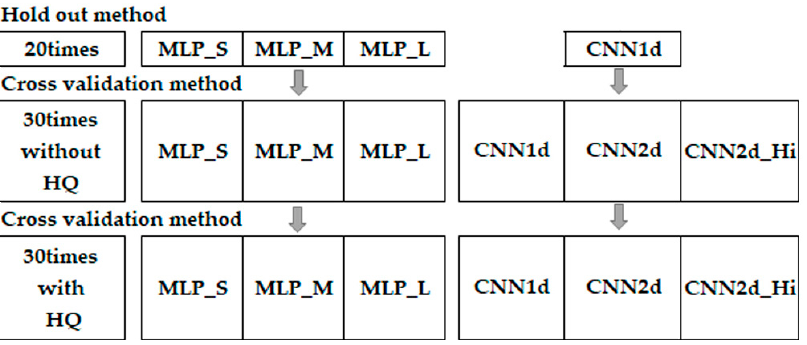
Figure 2. Flowchart of the